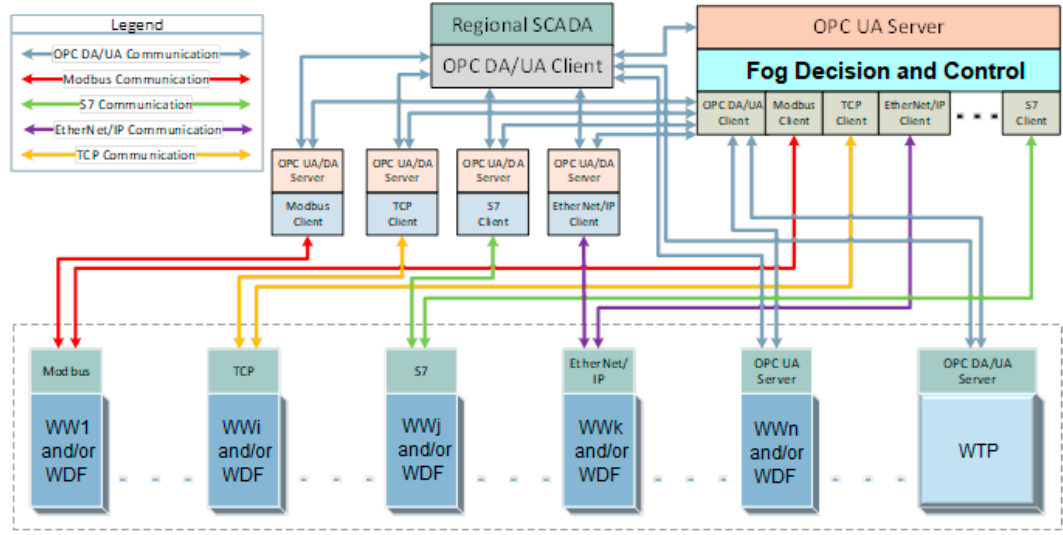
Figure 4. The fog computing decision and control solution (FDC) solution interfacing with the DWF and the regional/central SCADA control centre (WW—water well; WDF—water distribution facility; WTP—water treatment plant).